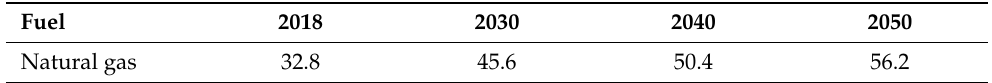
Table 5. Natural gas prices (PLN/GJ).